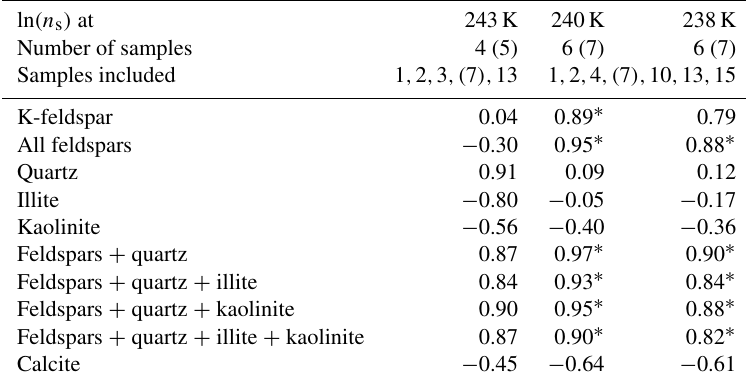
Table 6. Overview of the Pearson correlation coefficients of the sum of ice-active minerals and ln (n s ) at different temperatures of the samples where the mineralogy is representative for the size fraction smaller than 2.5µm. The names of the included sample numbers can be found in Tables 1 and 4. Only samples with FF between 0.1 and 0.9 were included for the correlations. The Etosha sample (7) was only included in the correlation with calcite because it does not contain feldspars, illite, or kaolinite and only traces of quartz. An asterisk indicates if the correlation was significant at the 0.05 level. ln (n s ) at 243K 240K 238K Number of